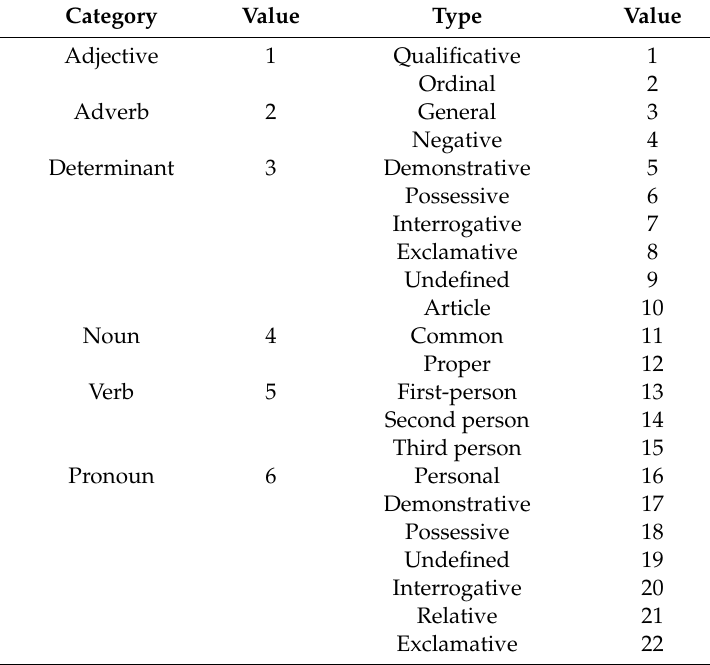
Table 5. Mapping rules for categories and types.